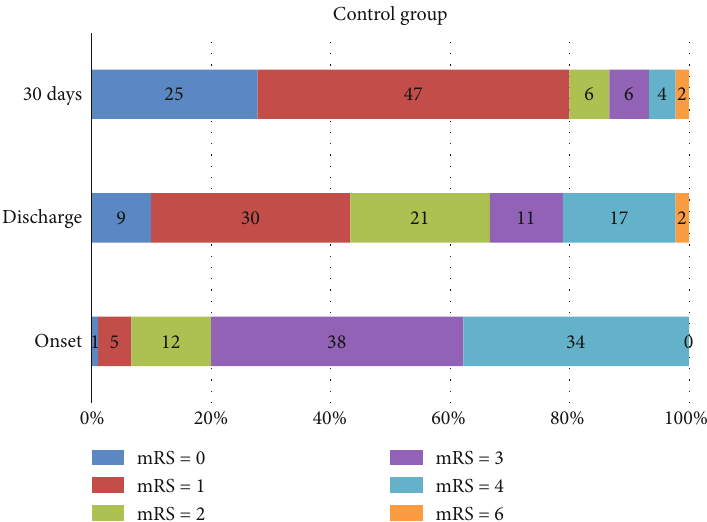
Figure 5: Modi fi ed Rankin Scale score distribution at baseline onset, discharge, and day 30 of stroke in the control group (standard treatment only).